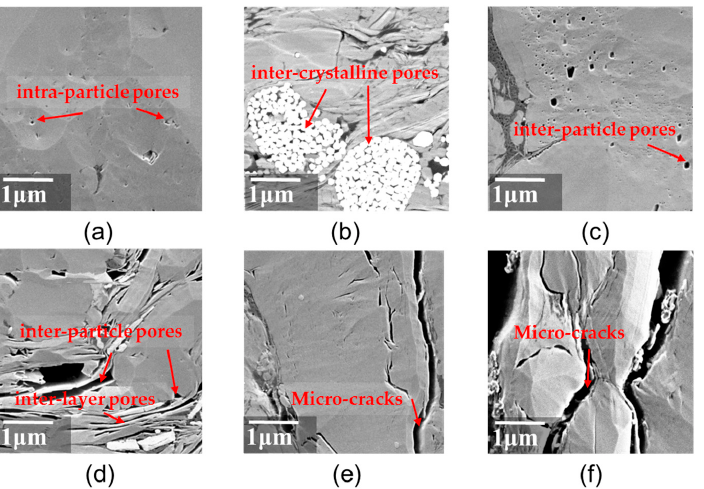
Figure 18. Inorganic pores. (a) inter-particle pores, (b) pyrite’s inter-crystalline pores, (c) inter- particle dissolution pores, (d) inter-particle and inter-layer pores, (e) and (f)